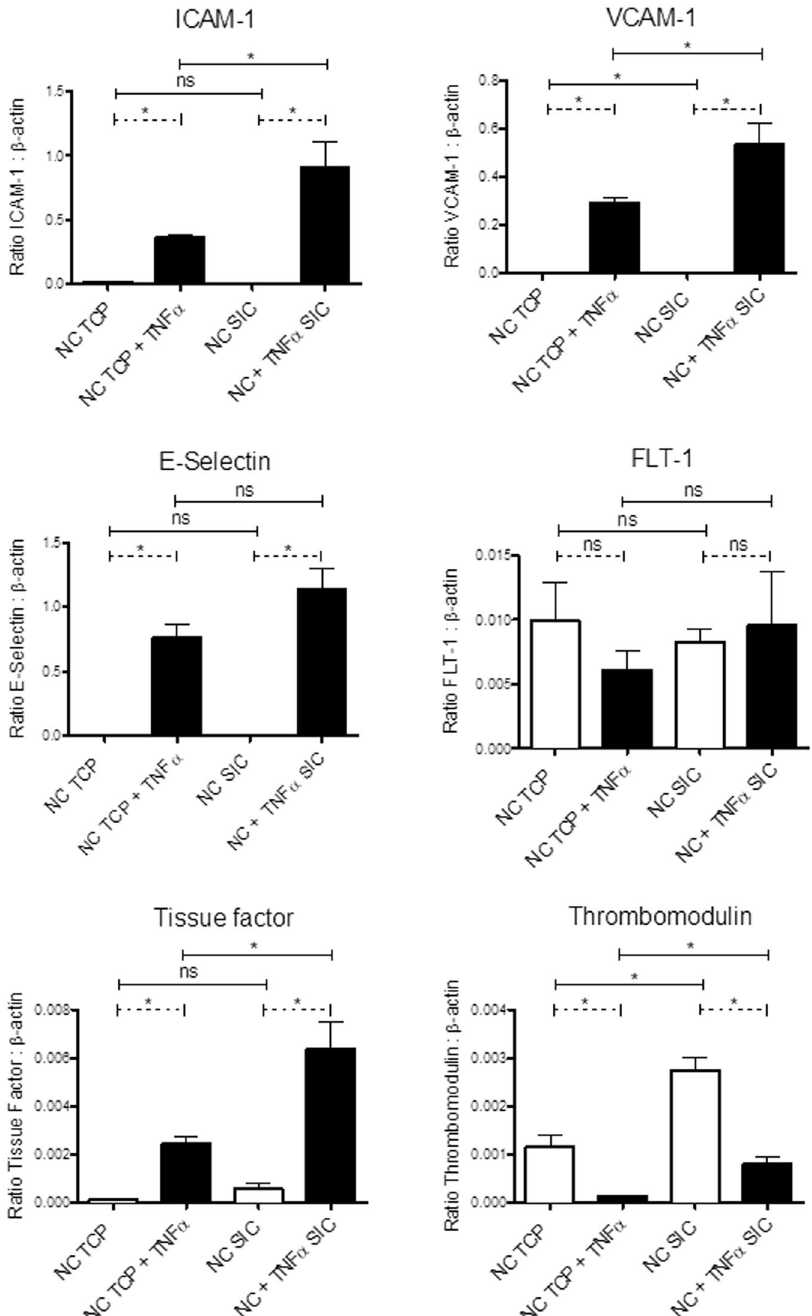
Figure 2. EC reactivity is comparable between TCP and SIC. Semi-quantitative real-time RT-PCR was used to determine mRNA levels, normalized to β -actin. Analysis of the endothelial phenotype (FLT-1), endothelial specific activation (ICAM-1, VCAM-1, E-Selectin) and thrombogenic state markers (tissue factor, thrombomodulin) of ECs on TCPs and SICs, with and without TNF α -stimulation indicated a comparable preservation of the biological reactivity of the ECs. The paired two-tailed t-test was used to determine statistically significant differences (p < 0.05) indicated by the asterisks ( * ). Statistically insignificant results are marked by “ns”. The results are depicted as group means ± standard deviation (n =